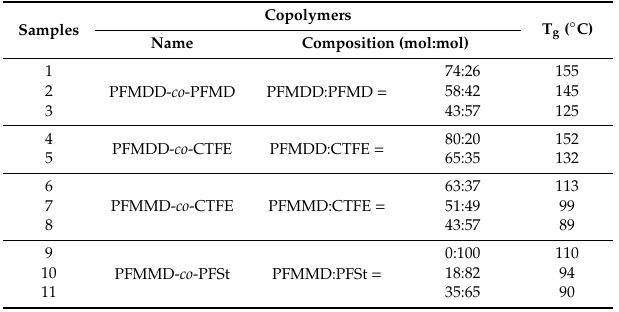
Table 2. Physical Properties of Various Perfluorodioxolane